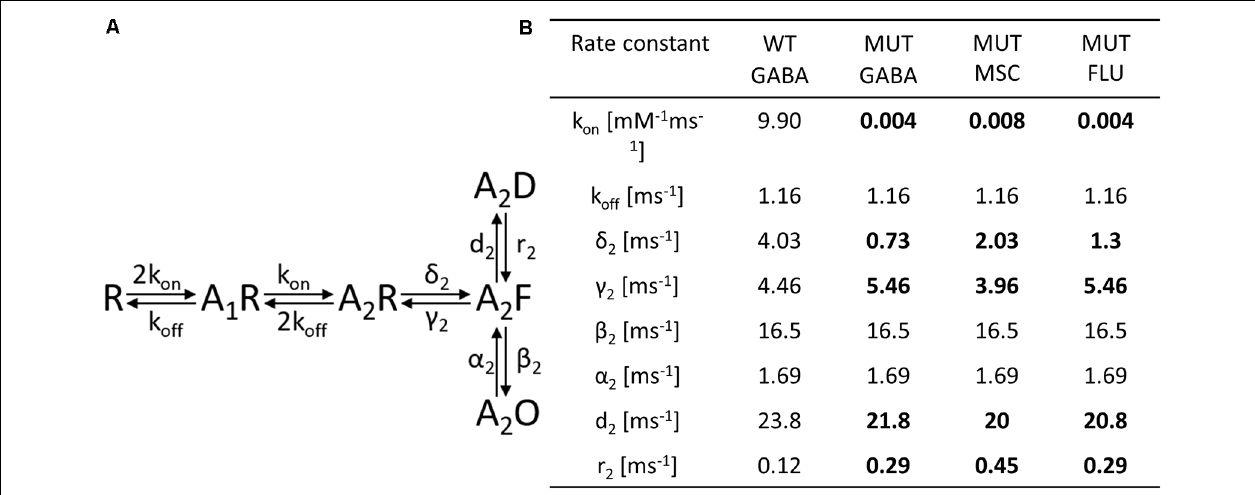
FIGURE 5 | Kinetic model simulations for macroscopic currents analysis. (A) Macroscopic kinetic model framework for GABA A R used for our simulations (Szczot et al., 2014). (B) Table presenting the rate constant values, for GABA-evoked responses for wild-type (WT) receptor and for currents mediated by mutated (MUT) receptors (GABA, GABA + FLU, and MSC). Values in bold font indicate rate constants for mutants for which trend analysis indicated changes with respect to WT-GABA.